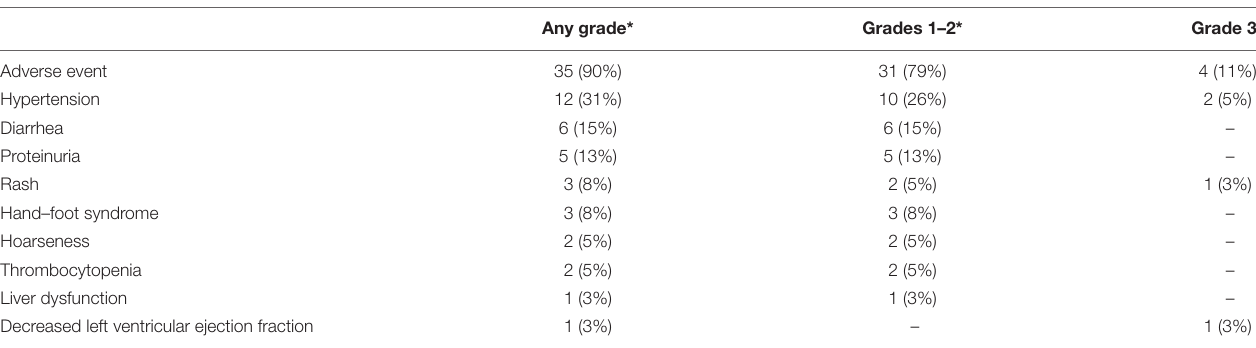
TABLE 3 | Treatment-related adverse events in all patients ( n = 39). Any grade* Grades 1–2* Grade